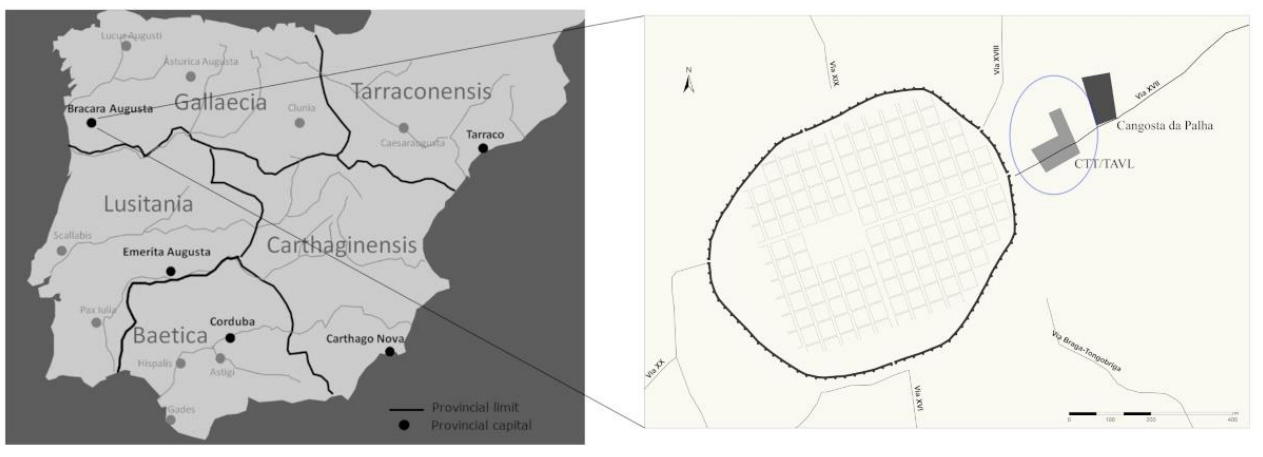
Figure 1. Location of the studied area of Via XVII necropolis in the Roman urban layout, on the Iberian Peninsula. Adapted from [6,17].